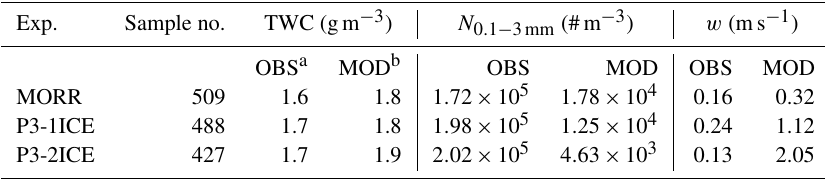
Table 2. Averaged TWC, N 0 . 1 − 3mm and air vertical velocity ( w ) of HIWC samples (TWC > 1gm − 3 ) at − 10 ◦ C. The differences in all averages between the simulations and observations pass the significant test for p < 0 . 05. Exp. Sample